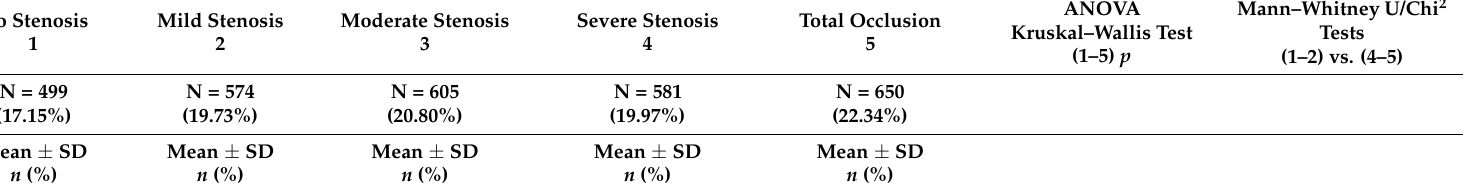
Table 2. Patient-, system- and procedure-related risk factors for procedure complexity and major